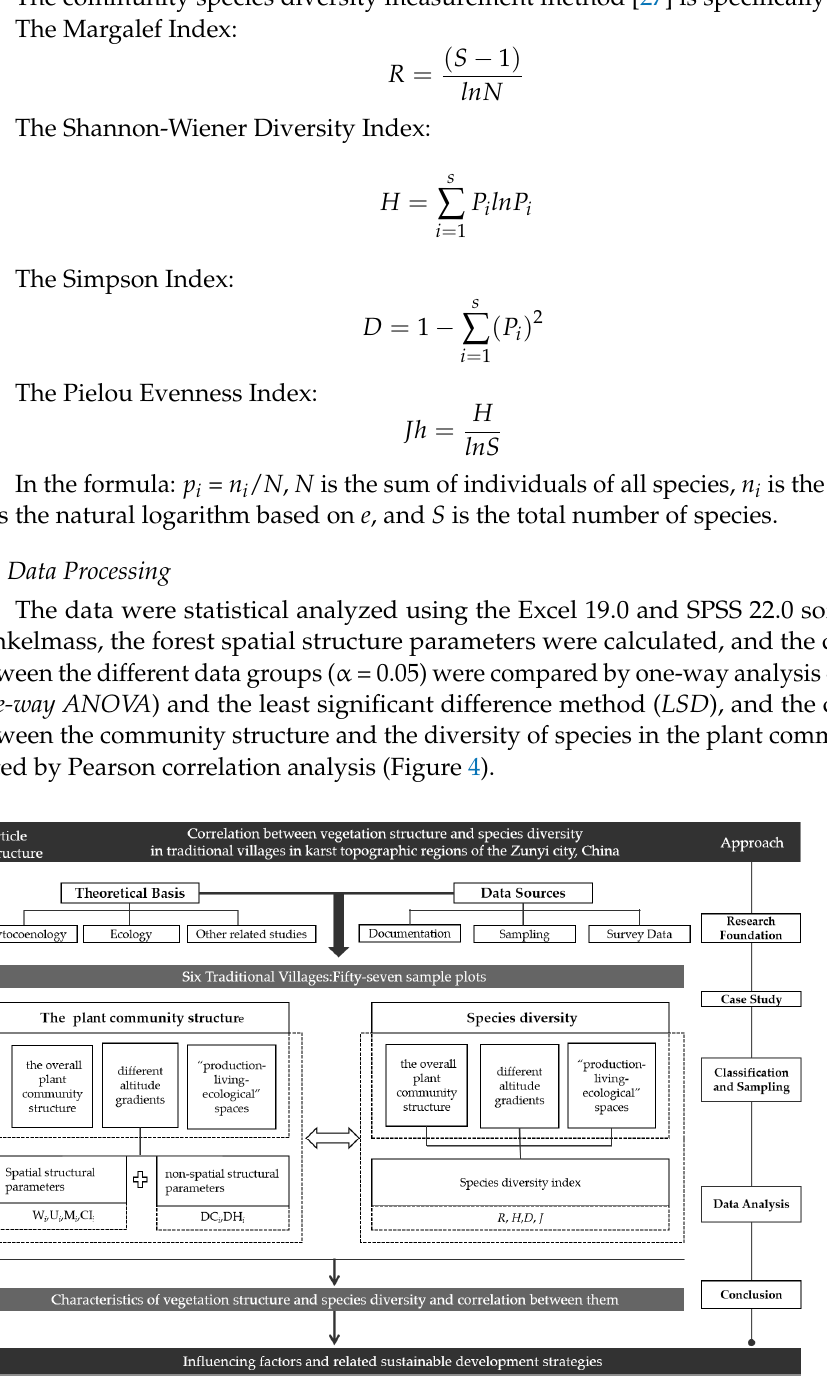
Figure 4. Research